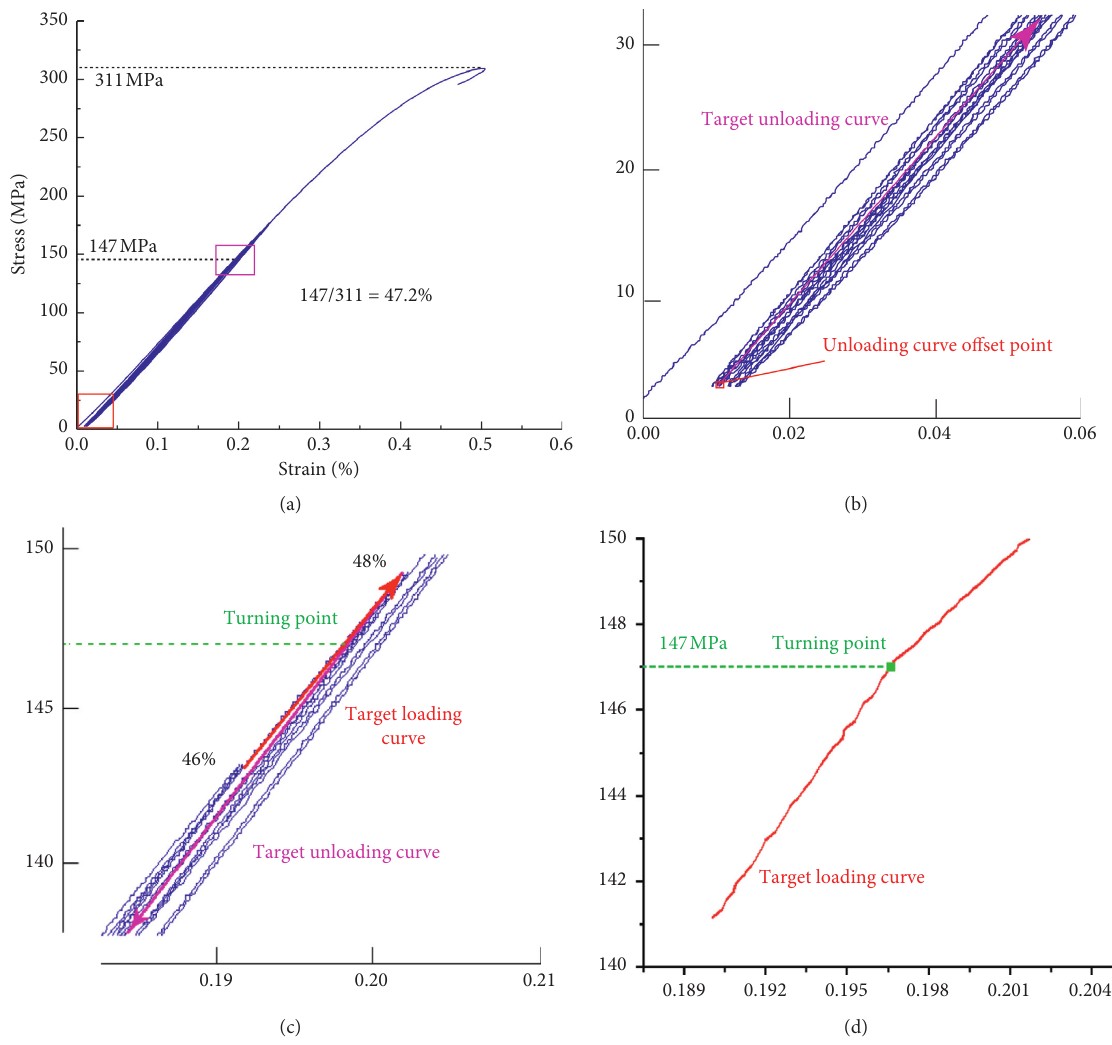
Figure 10: Data processing step of damage threshold with 10 MPa confining pressure: (a) the stress-strain curves in ascending step cyclic loading under 10MPa confining pressure; (b) target unloading curve evaluated process; (c) target loading curve evaluated process; (d) initial damage point evaluated